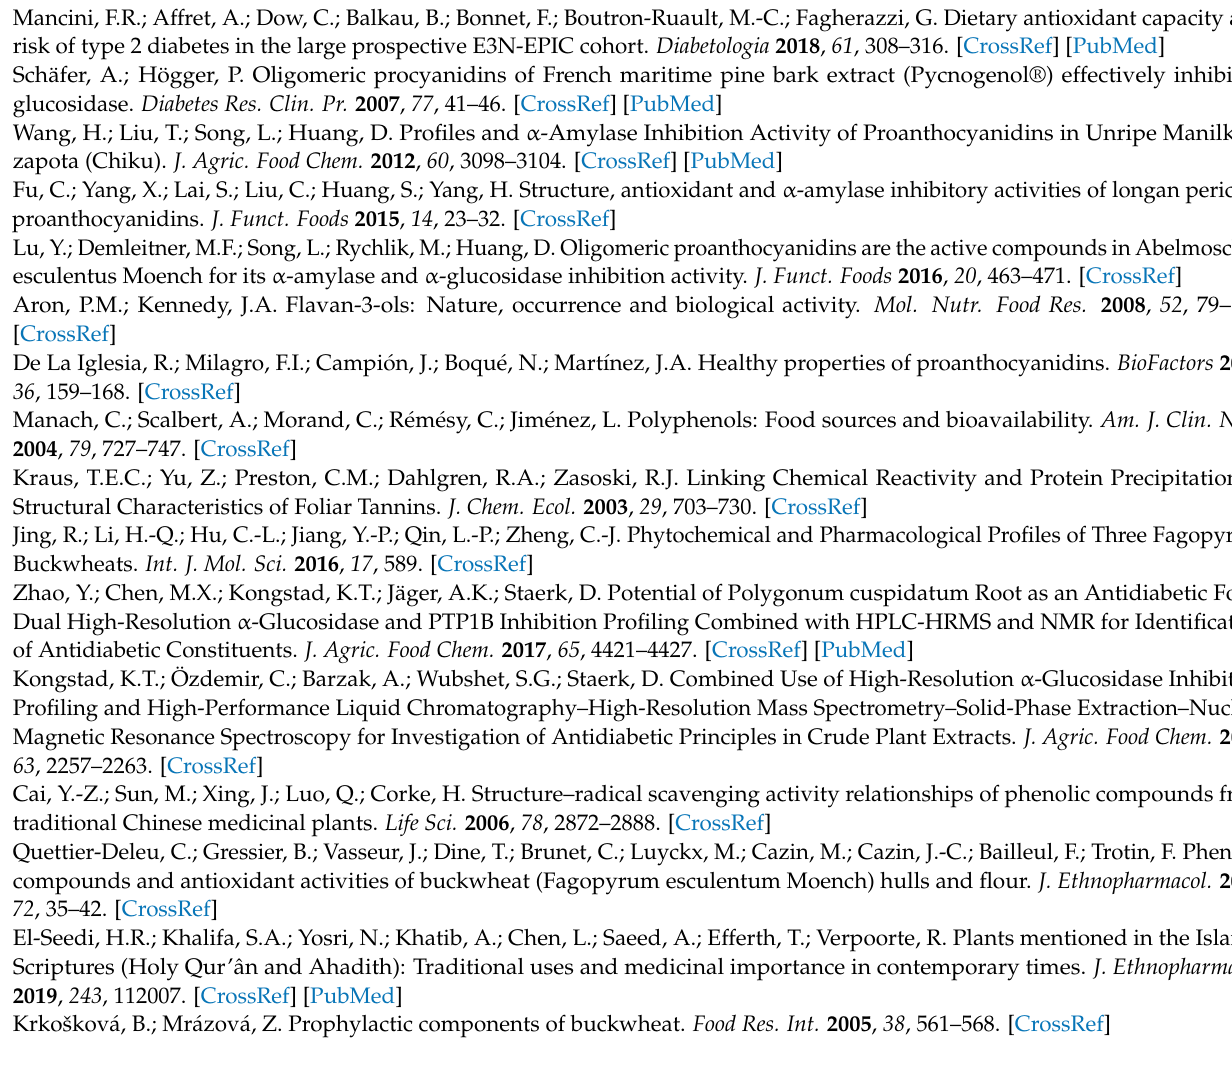
Supplementary Materials: Figure S1: The Chemical structure of typical flavane-3-ol monomers. Table S1: The abbreviations in this article. A brief introduction of the seven Polygonaceae plants used in this article is also available in the